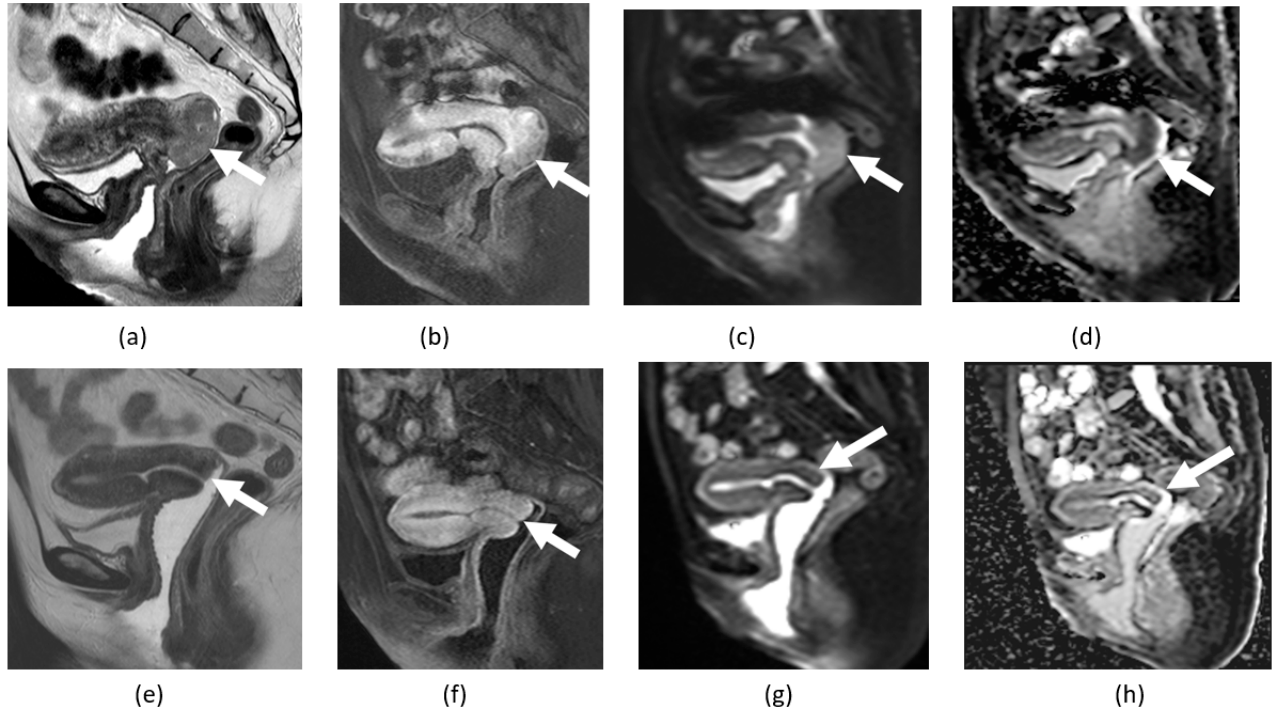
Figure 14. Sagittal T2- ( a ) and T1-weighted contrast-enhanced ( b ) images before treatment shows a large cervical mass (arrows) protruding into superior aspect of vaginal canal and exhibiting restricted diffusion on corresponding DWI ( c ) and ADC maps ( d ). Sagittal T2- ( e ) and T1-weighted contrast-enhanced ( f ) images after treatment shows resolution of the lesion (arrows) and absence of areas with restricted diffusion suggesting no residual viable tumor on corresponding DWI ( g ) and ADC maps ( h ).